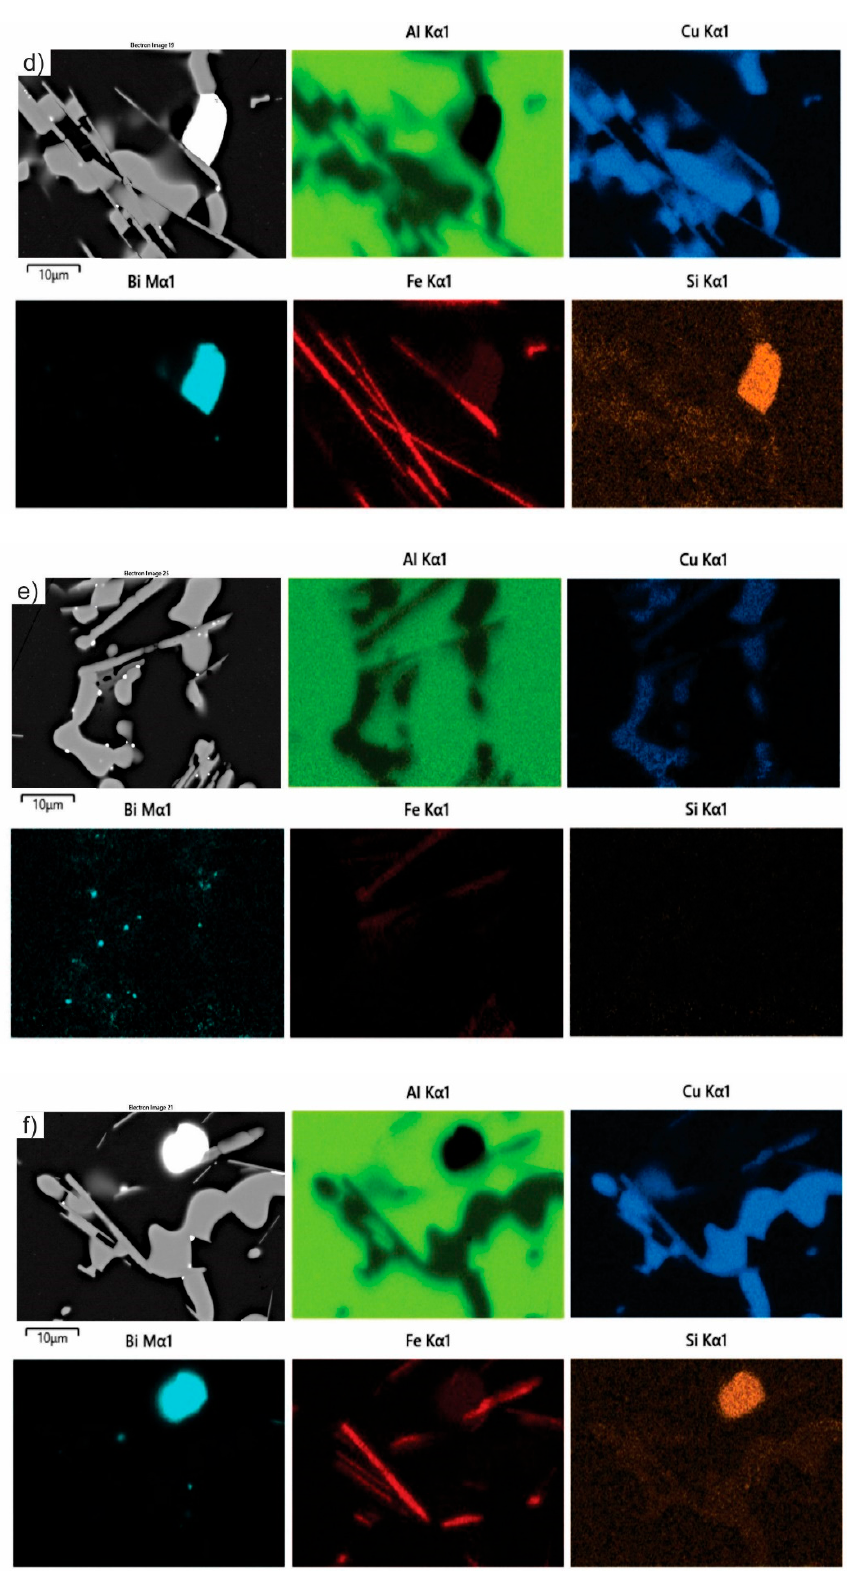
Figure 6. EDS individual elemental mapping analysis of as-cast ( a ) and homogenised samples at 520 °C for 4 h ( b ), 5 h ( c ), 6 h ( d ), 7 h ( e ), and 12 h ( f ) from modified EN AW 2011 aluminium alloy .